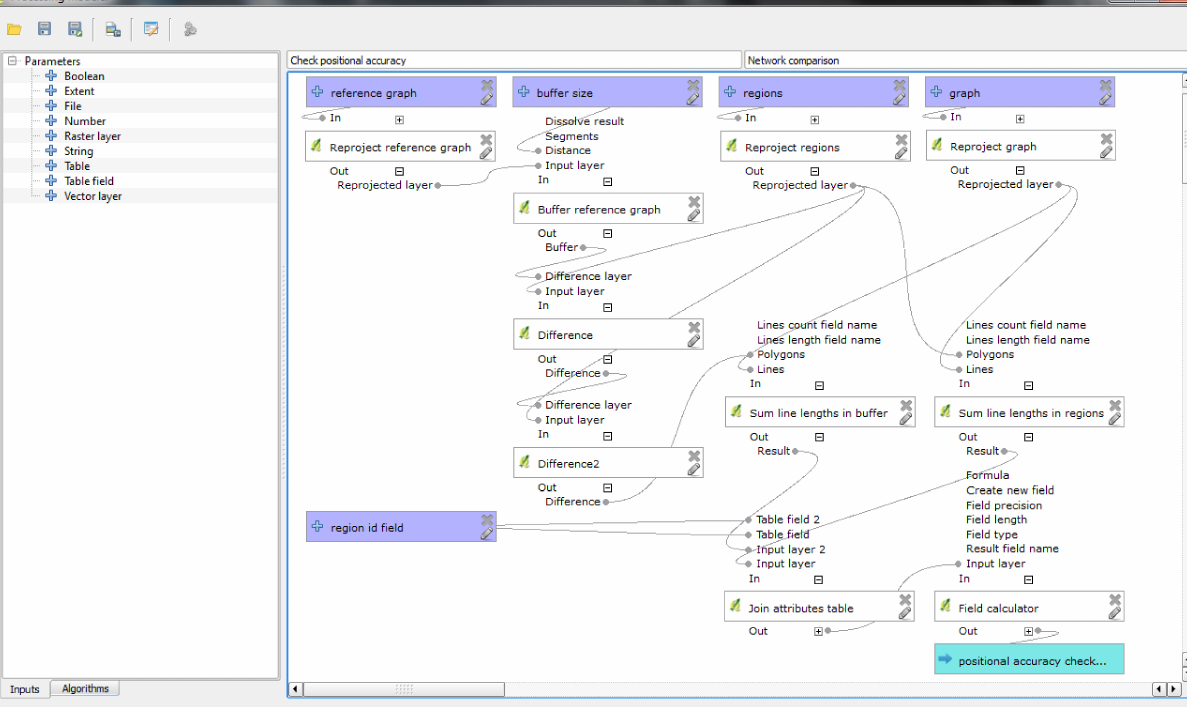
Figure 8. Positional accuracy comparison model; updated version of the model published in [17].